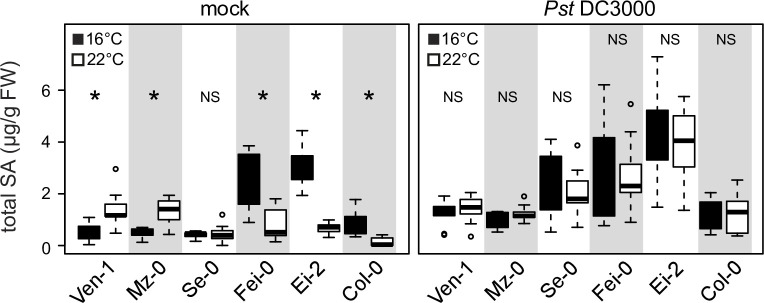
Inducibility of total SA by Pst DC3000 of leaves at 16°C and at 22°C.Leaf total SA contents in 5-week old A. thaliana accessions with different temperature-modulated SA contents were assessed at 24 h after spray-treatment with 10mM MgCl2 (mock) or Pst DC3000 (OD600 = 0.15). Three individual plants per experiment were assessed per experiment and three independent experiments performed (n = 9). Significant differences between temperatures after Student t-test with p-value<0.05 are marked with a star. NS = not significant.